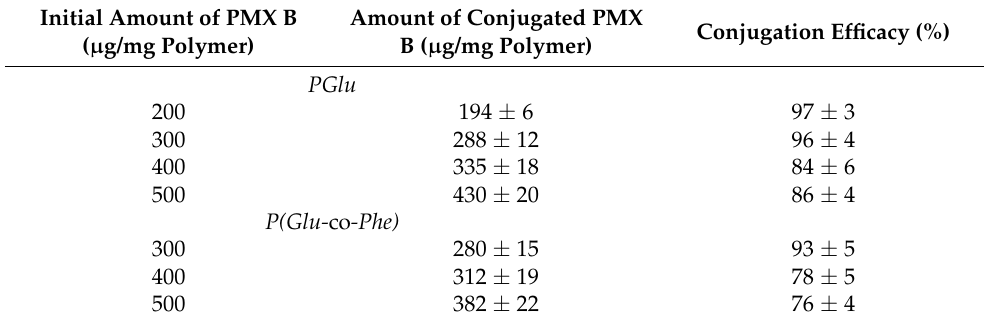
Table 2. Efficacy of PMX B conjugation with PGlu or P(Glu- co -Phe) depending on the initial amounts of